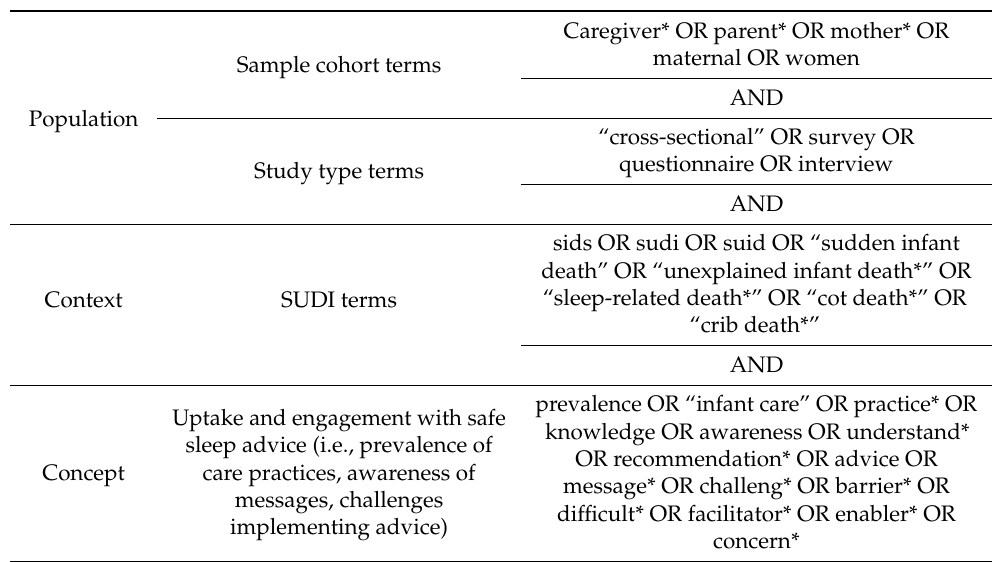
Table 1. Search strategy string.